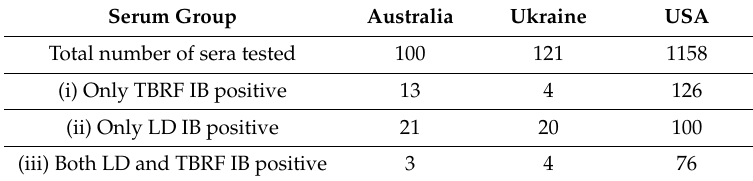
Table 4. TBRF and Lyme disease (LD) line immunoblot findings in sera of patients with symptoms of LD. Serum Group Australia Ukraine USA